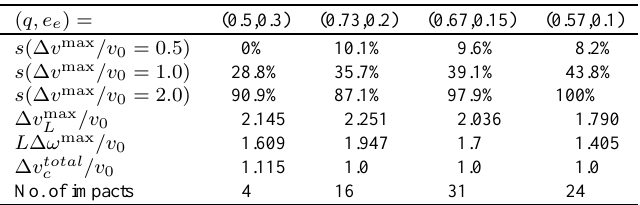
Table 1 Some example product configurations in terms of values of ( q,e e ) that yield, roughly, a 10% safe zone in the middle of the bar where the velocity shock is less that v 0 / 2 while substantially the rest of the bar does not experience shocks exceeding 2 v 0 . The first configuration, ( q,e e ) = (0 . 5 , 0 . 3) , is a reference configuration (with unifrom mass distribution) that does not have the required safe